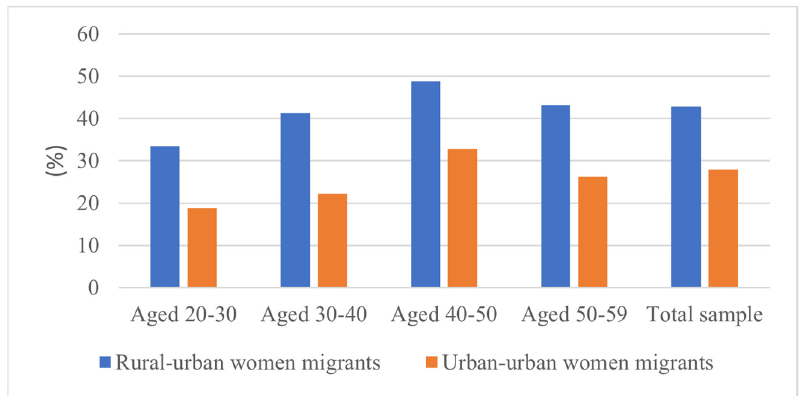
Figure 2. The weight of overwork between rural–urban and urban–urban women migrants in China.